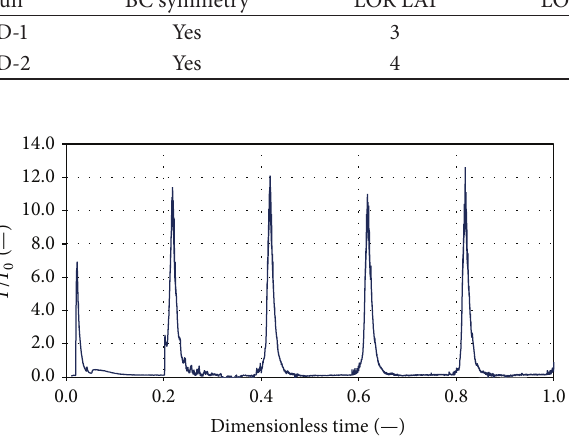
Figure 16: Dimensionless resistant torque curve for run 3D-2.